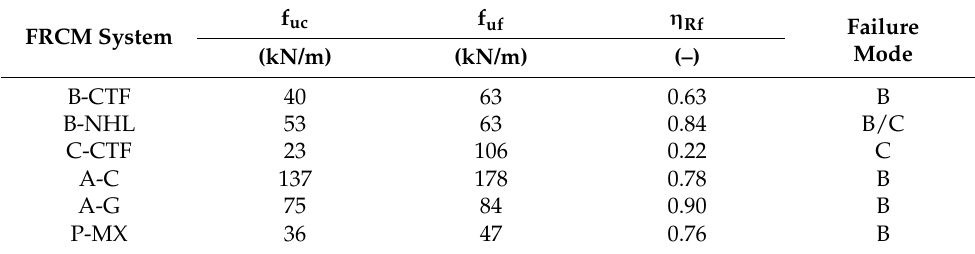
Table 11. Tensile strength of composite (f uc ) and fabric (f ut